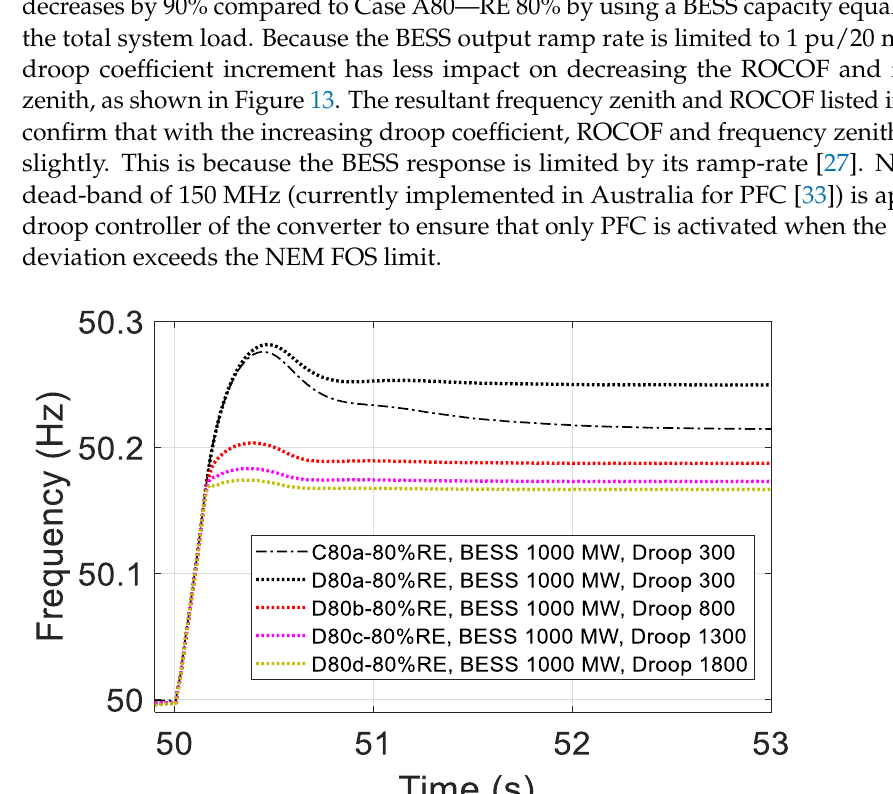
Figure 14. BESS output power under different droop coefficients when no PFC response is ob- tained from SGs. Table 10. ROCOF and frequency zenith for Group D. Cases D